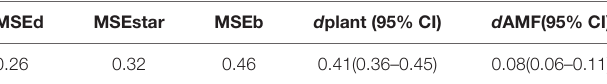
TABLE 1 | Phylogenetic signals of plant-AMF based on incidence matrix